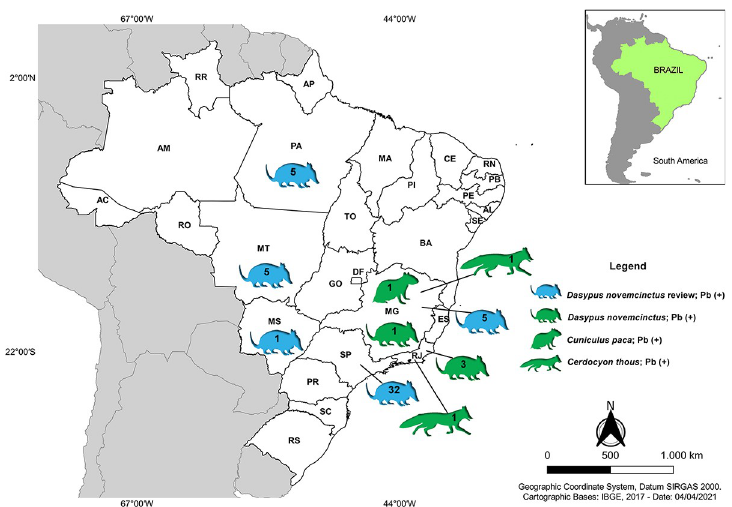
Fig 2. Distribution of Dasypus novemcinctus , Cuniculus paca , and Cerdocyon thous , with Paracoccidioides spp. molecular detection or isolation in culture across Brazilian states. Data were retrieved from the literature (blue animals) and this study (green animals). Numbers in animals’ symbols represent the amount of animals with positive Paracoccidioides results in each state. Base map retrieved from the Brazilian Institute of Geography and Statistics (IBGE).